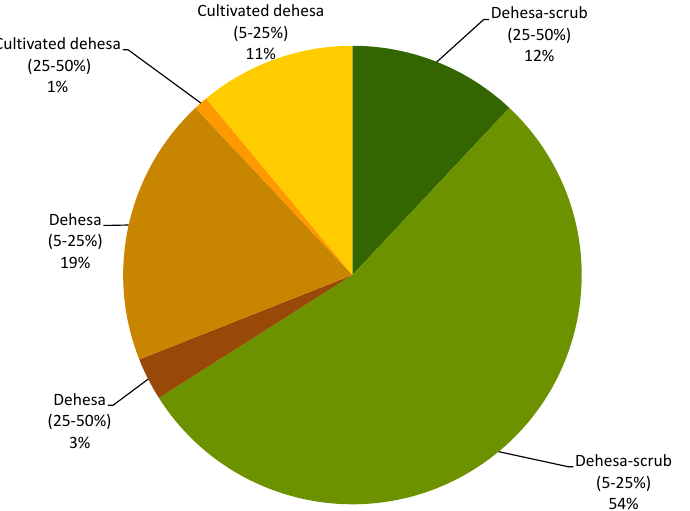
Figure 5: Types of dehesa that have disappeared between 1956 and